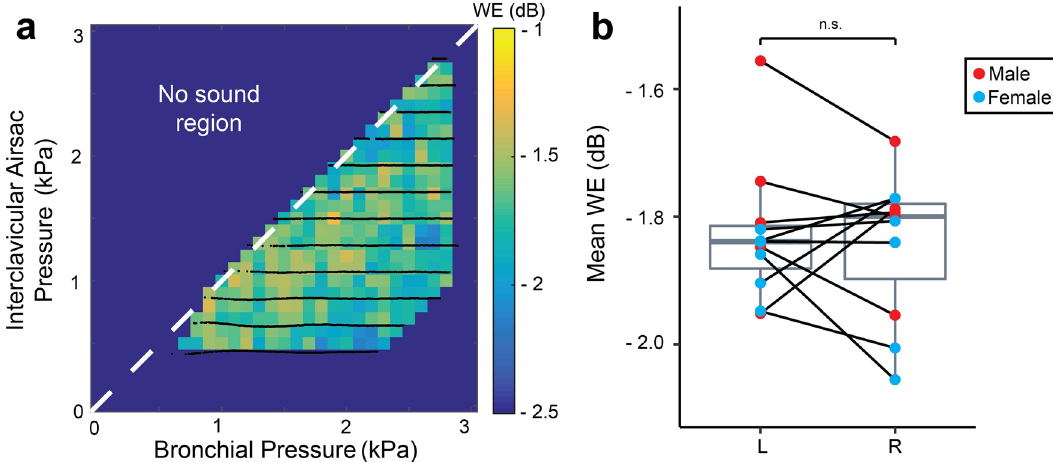
Figure 3. Wiener entropy is not affected by pressure in the adult zebra finch hemi-syrinx. ( a ) Wiener entropy (WE) produced in the pressure control space for the left hemi-syrinx of an adult male zebra finch (100 DPH). ( b ) Mean WE of the left and right hemi-syrinx was not significantly different between male and female zebra finches or for left and right hemi-syrinxes. For statistics see Supplementary Table S1.